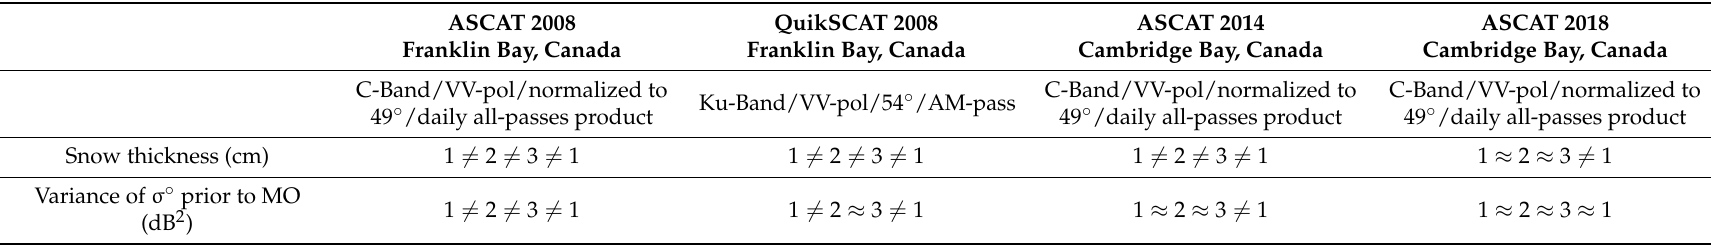
Table 2. Inter-site assessment of statistically significant differences of snow thickness and winter σ ◦ variance. Site numbers are as in Table 1. Snow thickness is assessed using Welch’s t-test, σ ◦ variance is assessed using an F-test. Both are two-tailed, assessed at 95% confidence